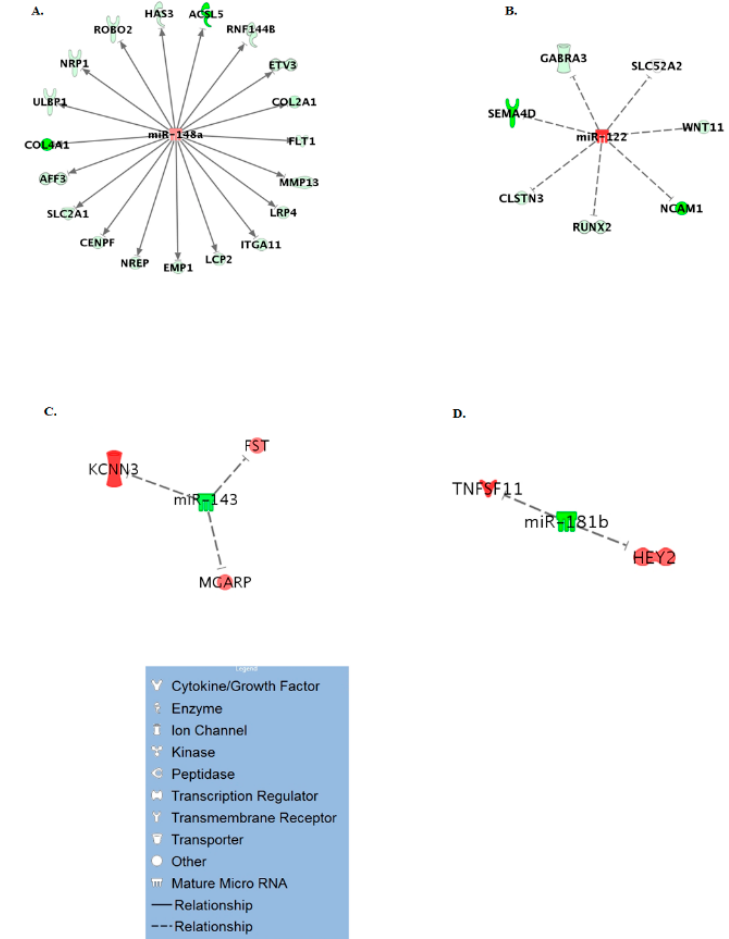
Figure 2. miR-mRNA interactome for differentially expressed miRs in ageing. Significantly differentially expressed miRs were paired with differentially expressed mRNAs from our original cartilage study. ( A ) miR-148a, ( B ) miR-122, ( C ) miR-143, ( D ) miR-181b. The legend for individual molecules is shown. Genes in red are upregulated and green downregulated in old chondrocytes/cartilage compared to young, and depth of colour correlates to fold expression change.